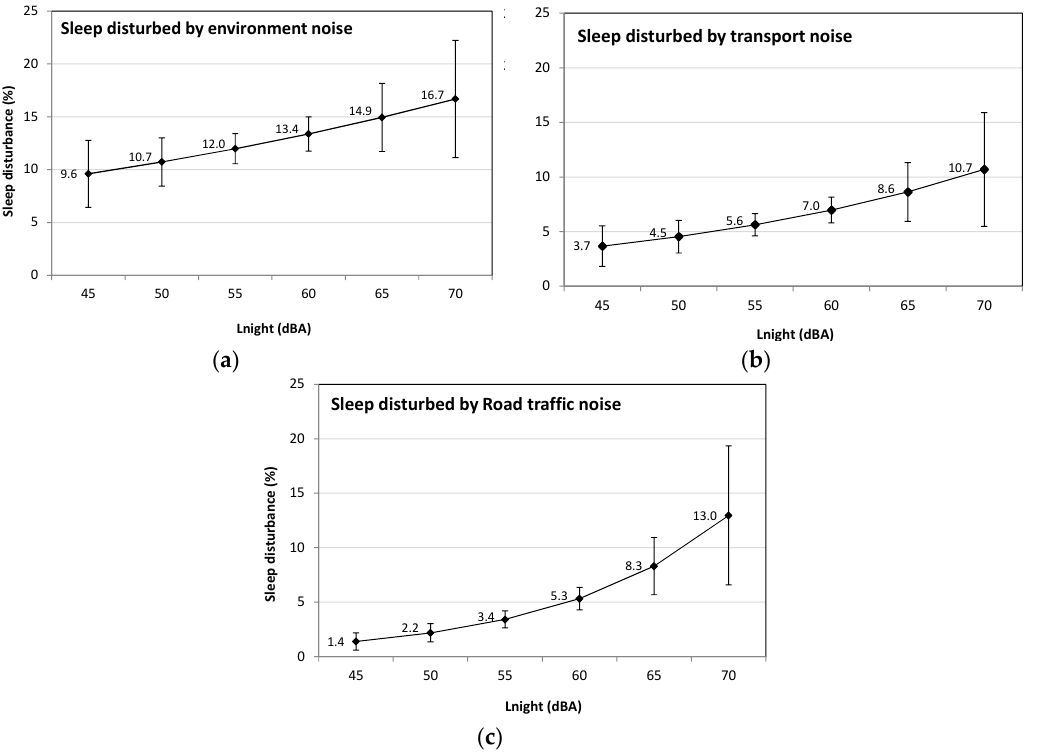
Figure 4. Marginal proportions and 95% CI (confidence interval) of sleep disturbance by environmental noise ( a ); transportation noise ( b ); and road traffic in relation ( c ) to L Night estimated by the LUR noise model in the weighted study sample.